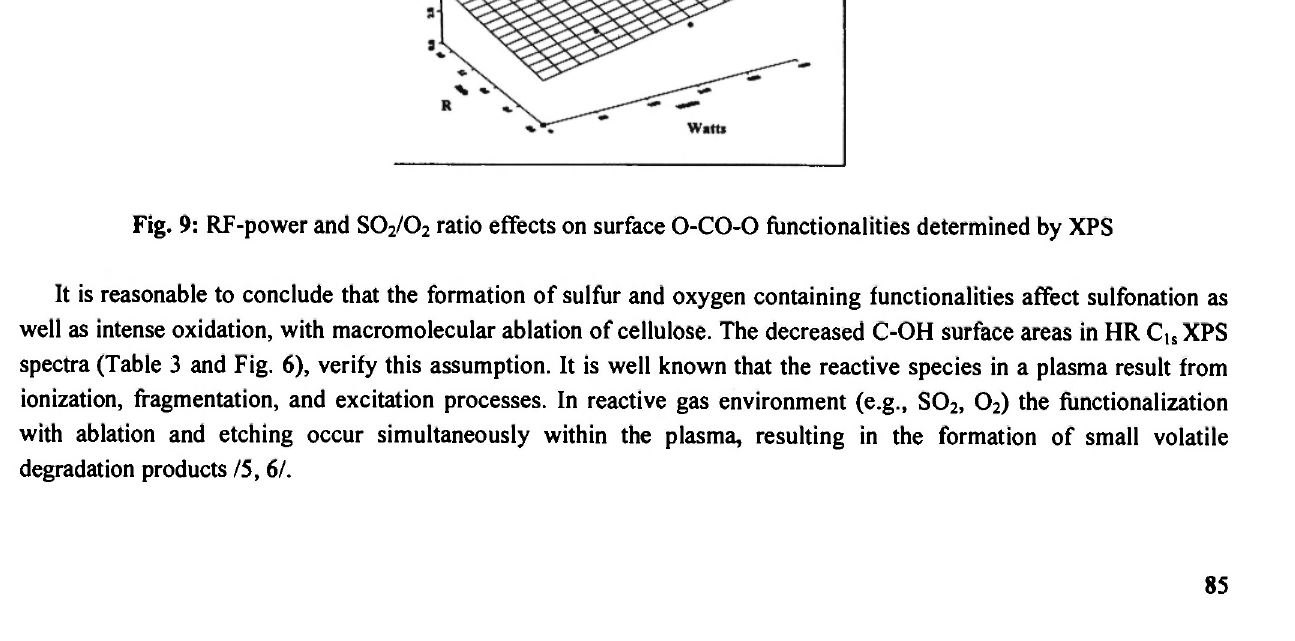
Fig. 8: RF-power and S0 2 /0 2 ratio effects on surface 0=C-0H functionalities determined by XPS